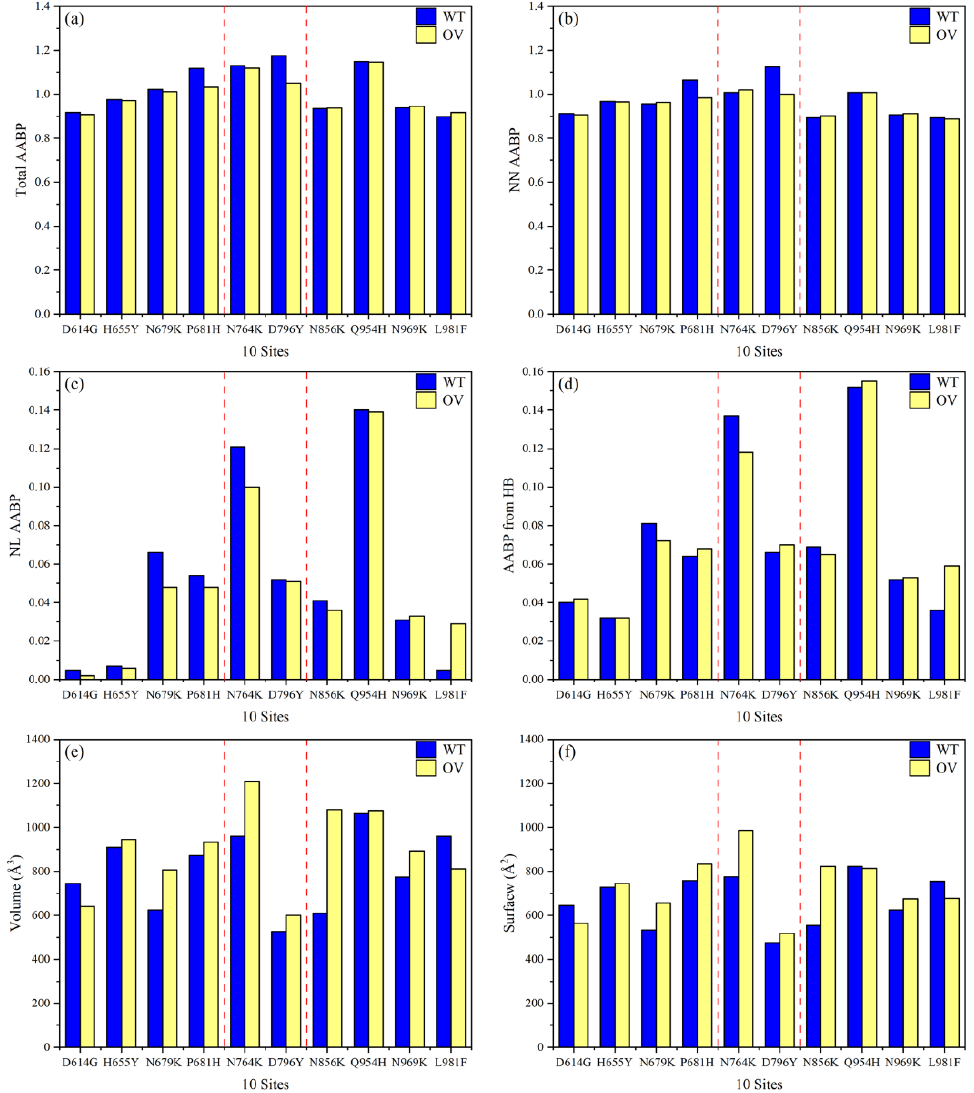
Figure 2. Comparison of interatomic interactions and geometry features of 10 OV mutations with their corresponding WT. ( a ) Total AABP, ( b ) NN AABP, ( c ) NL AABP, and ( d ) AABP from HB, for 10 unmutated (WT) and mutated (OV) AAs. ( e ) Volume, and ( f ) Surface. The two dashed red lines show the two cleavage sites.